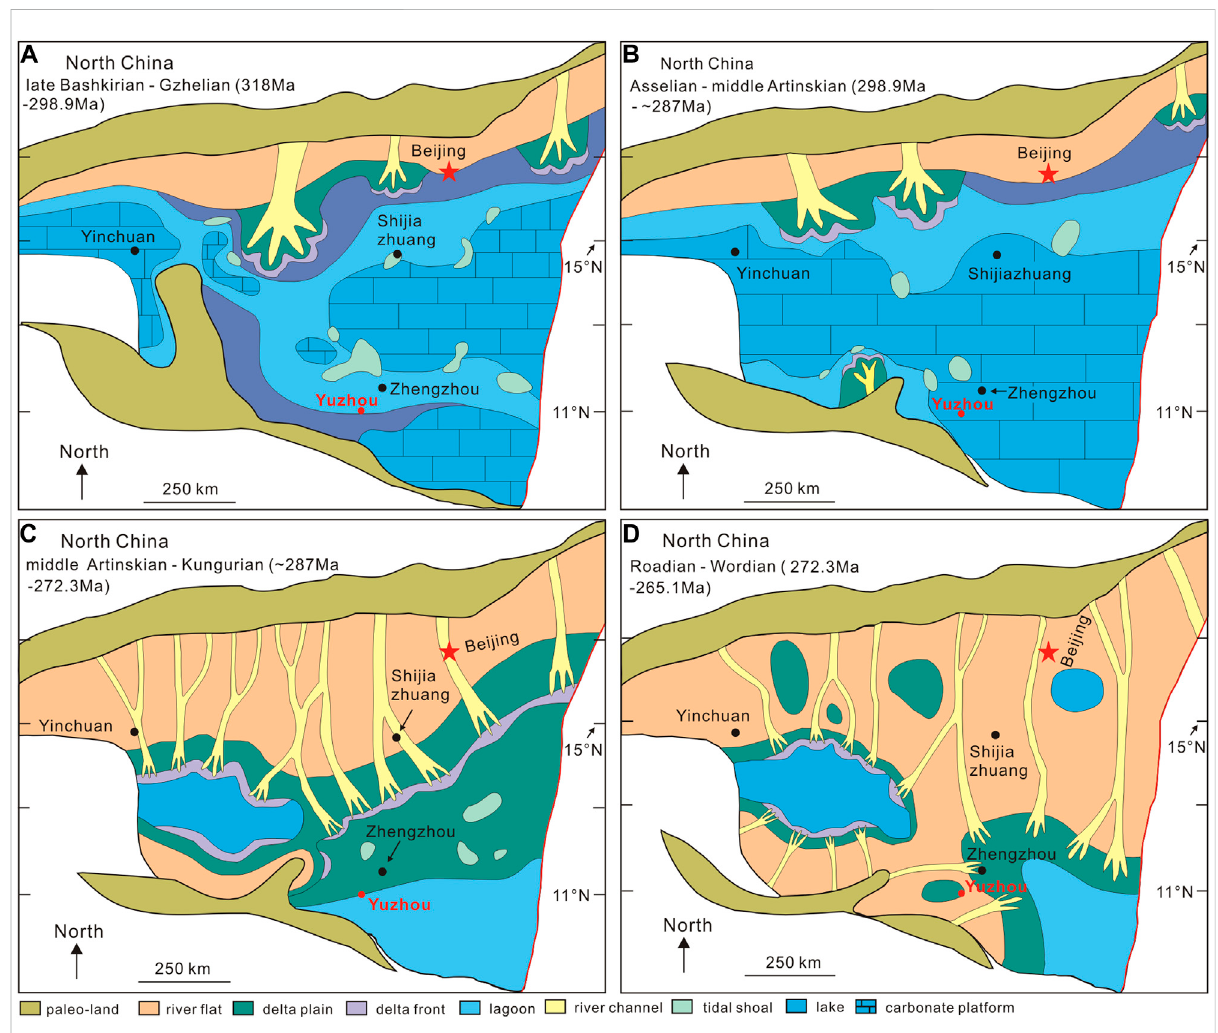
FIGURE 8 Lithofacies paleogeographic map from the late Bashkirian to Wordian (A – D) in the North China Plate (Shao et al., 2014).